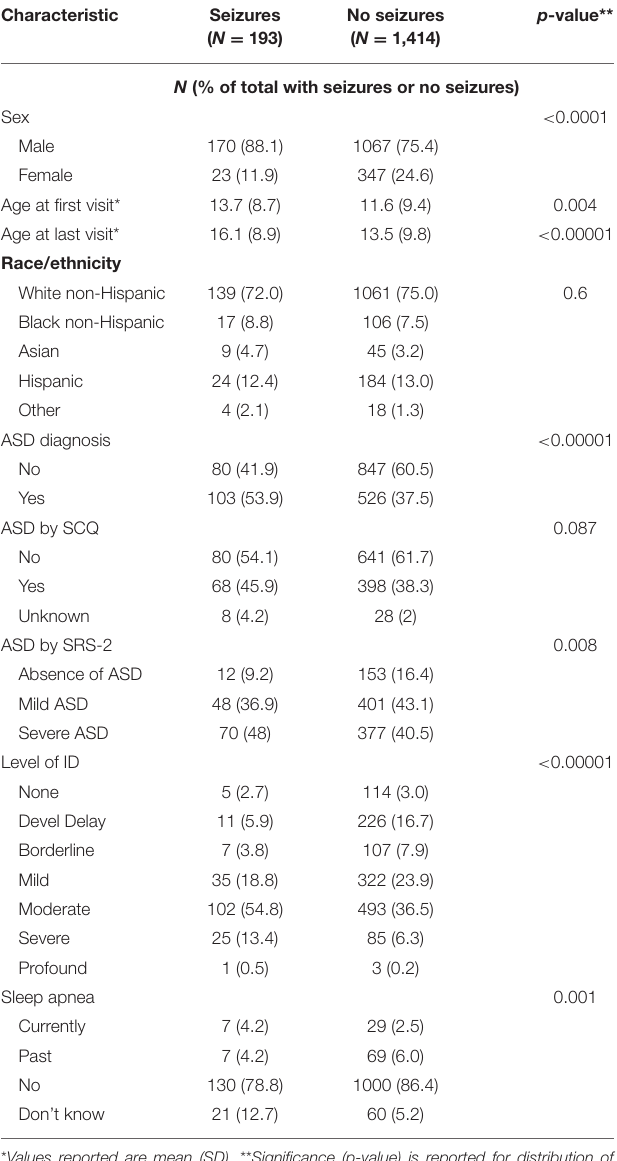
TABLE 2 | Association of cohort characteristics with seizures.